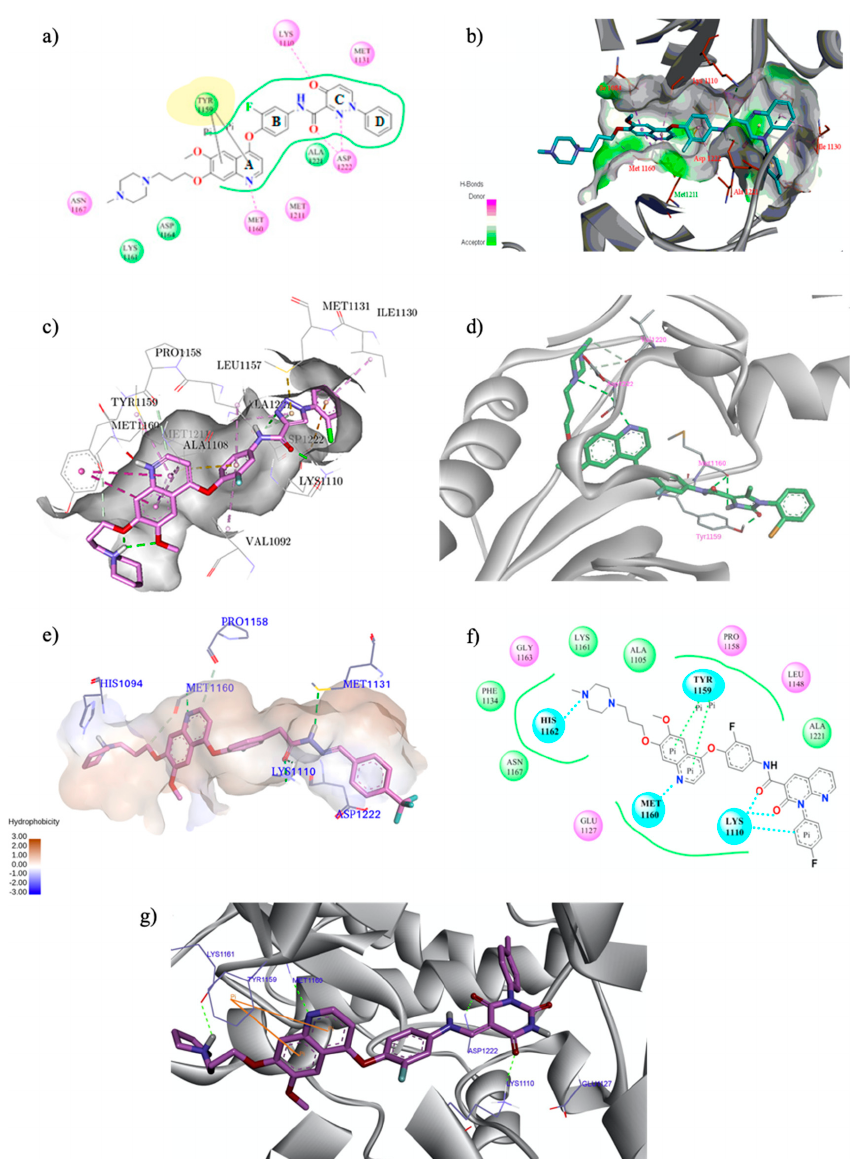
Figure 6. Binding models with c-Met kinase domain of quinoline- based compounds ( a ) 3 [35]; ( b ) 4 [36]; ( c ) 7 [38]; ( d ) 9 [40]; ( e ) 10 [41]; ( f ) 16 [48]; ( g ) 19 [51].